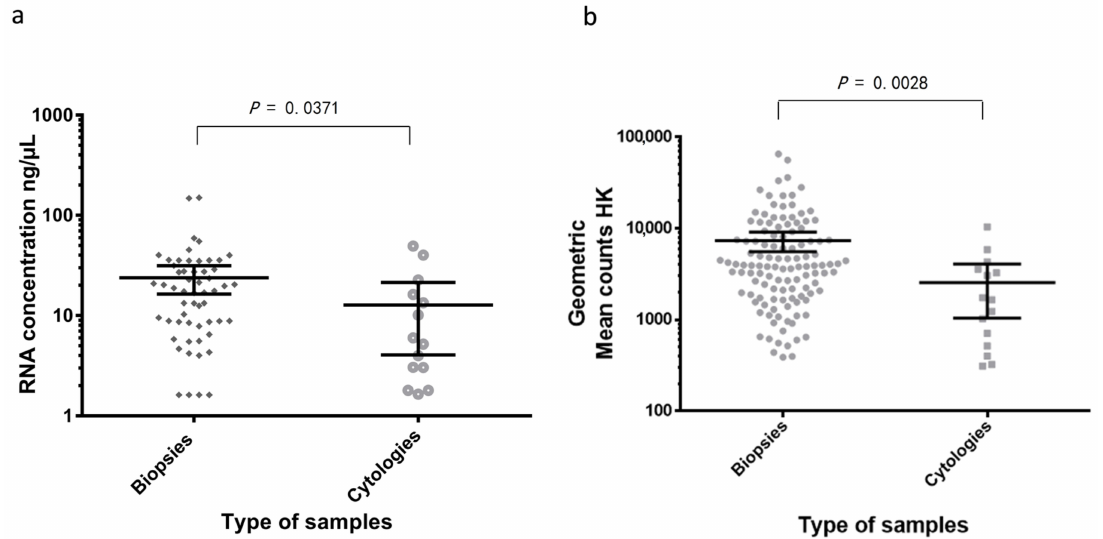
Figure 2. ( a ) Comparison of RNA concentration in ng/ µ L in biopsies ( n = 56) vs. cytologies ( n = 14). ( b ) Comparison of the geomean of housekeeping (HK) mRNA levels in biopsies ( n = 120) and cytologies ( n =